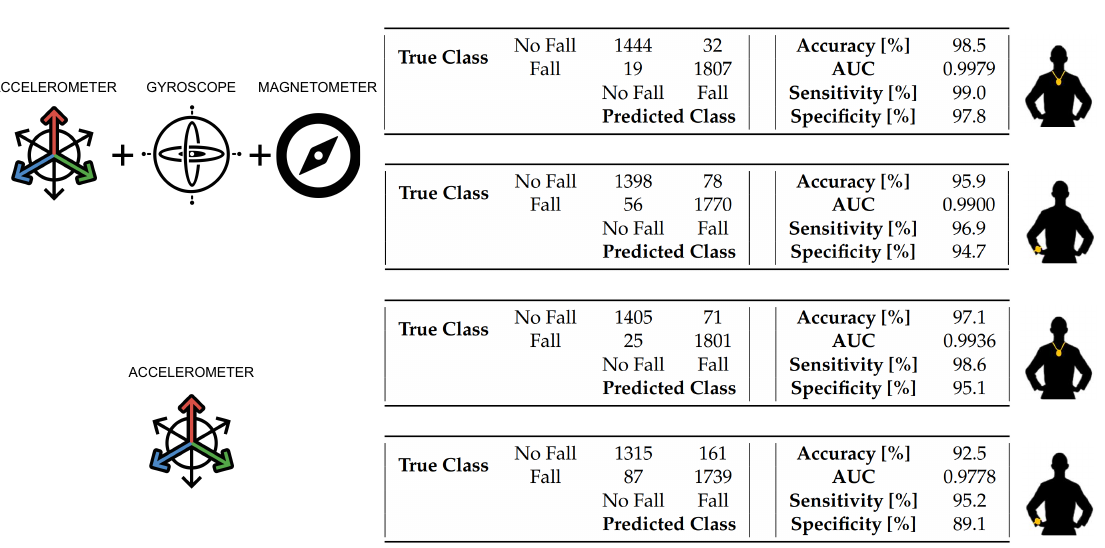
Figure 8. Performance of the model as a function of the position of the sensor (wrist vs chest position) used to derived data features utilized as input the proposed machine learning-based algorithms. Results are shown for analyses based on data collected using nine-axis units (i.e., accelerometer, gyroscope, and magnetometer time series) and for analyses based on data collected using only the accelerometer time series.